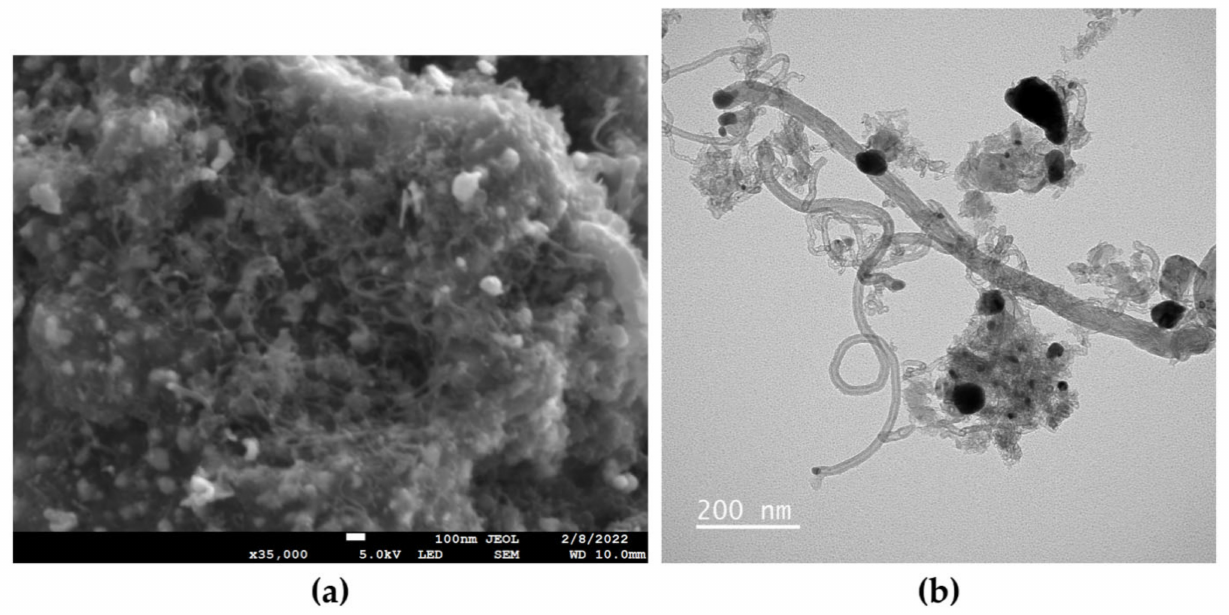
Figure 10. ( a ) SEM and ( b ) TEM images of the product obtained by the calcination of the [TPrA][Co 0.5 Ni 0.5 (dca) 3 ]